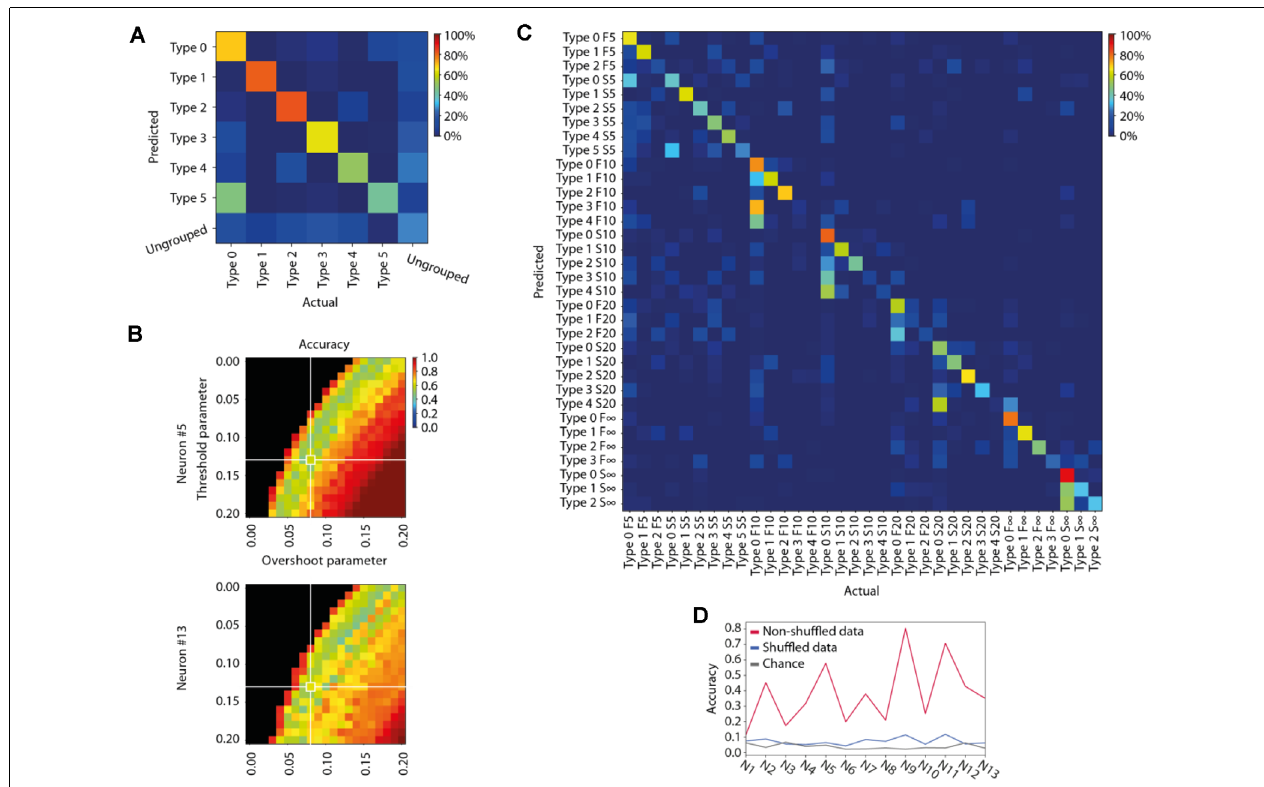
FIGURE 3 | Specificity of the different response types evoked by the same stimulation patterns in the same neuron. (A) Confusion matrix for the members of each identified response type for the sample stimulation pattern and neuron illustrated in Figures 2A,B . Decoding accuracy for each response type is indicated by the color code indicated in the calibration bar. (B) Sensitivity analysis of the parameter settings of our response type clustering method illustrated for two different neurons, here with respect to the average response type decoding accuracy (see A ) but across all stimulation patterns. (C) Confusion matrix for all response types identified for all stimulation patterns for this sample neuron. Same color code as in (A) . (D) To illustrate the specificity of the response types recorded across all eight stimulation patterns, this plot indicates the decoding accuracy across all stimulation patterns for each neuron. The figure also displays the chance level for each neuron, and the decoding accuracy when the responses recorded for each neuron were